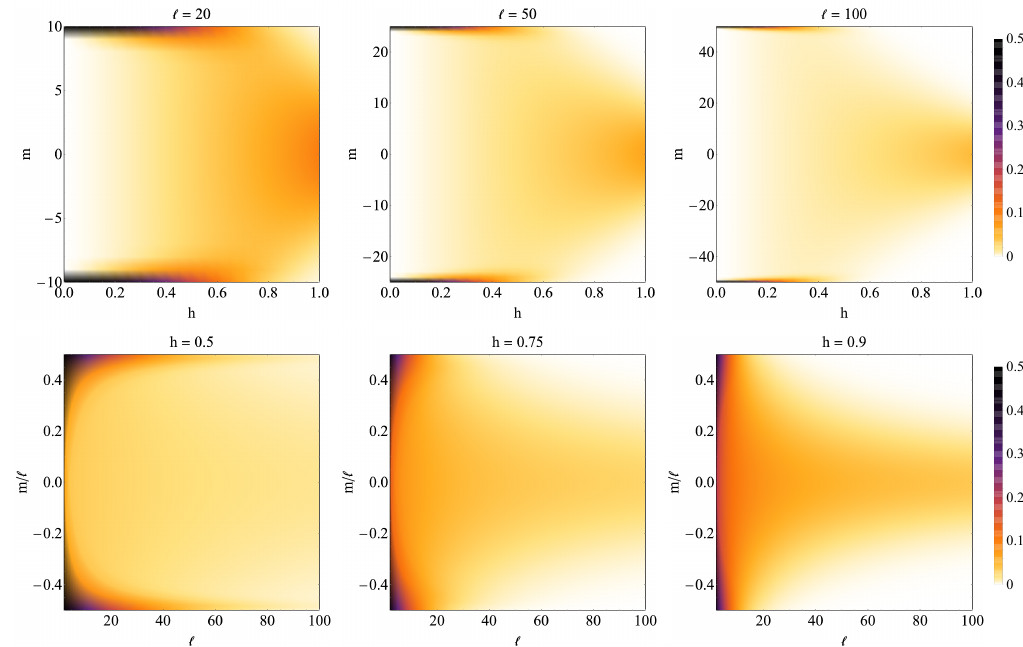
Figure 3: Color density plot of the PDF of the subsystem order parameter in the stationary state after quenching the transverse field h within the ferromagnetic re- gion. ( top ) Stationary PDF for different subsystem dimensions (cid:96) = 20, 50, 100 as a function of the post-quench transverse field h ∈ [ 0,1 ] . ( bottom ) The same PDF as a function of the subsystem size (cid:96) ∈ [ 2,100 ] for fixed value of the post-quench field h = 0.5, 0.75,